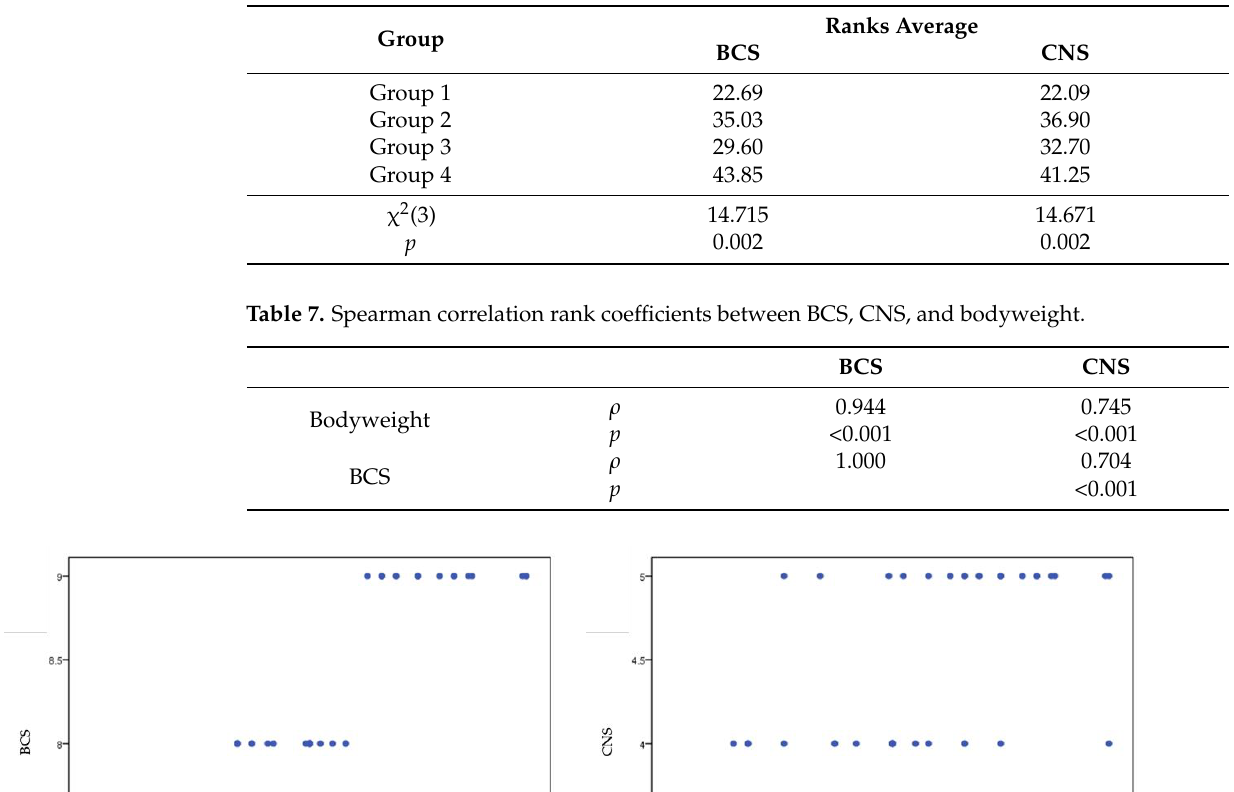
Table 6. Results of Kruskal–Wallis test used to compare BCS and CNS ranks.